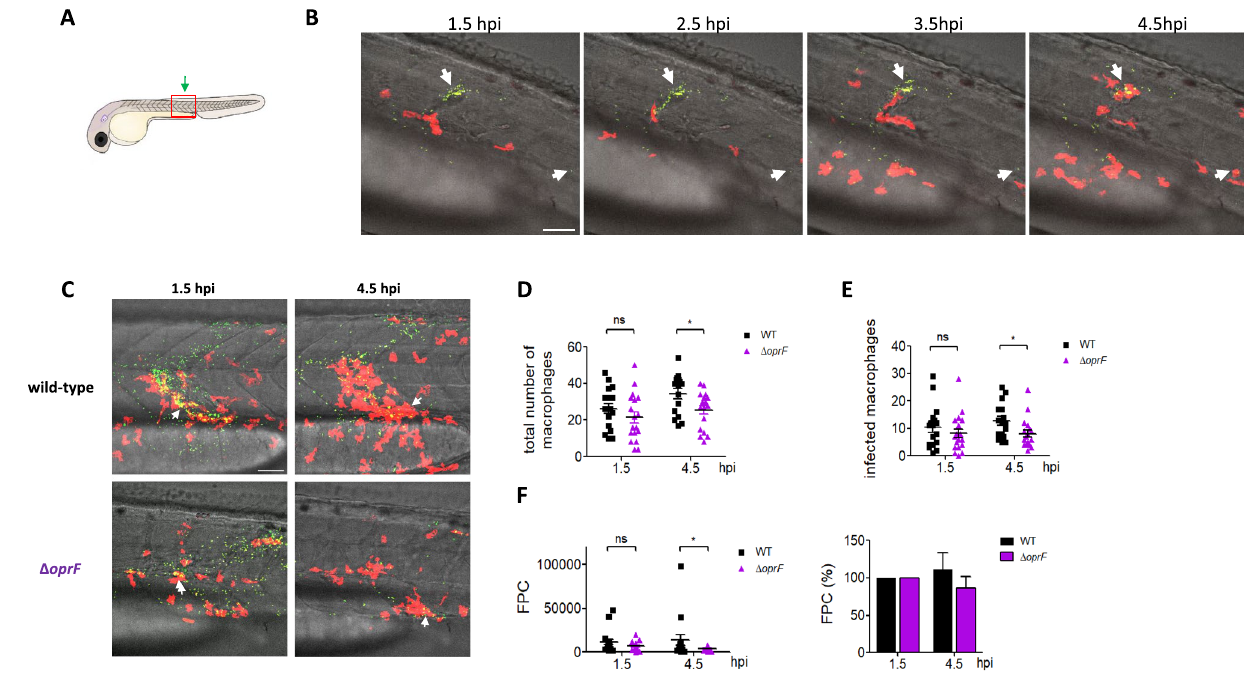
Figure 2. Real-time visualization and quantification of phagocytosis of P. aeruginosa after local injection into muscle of wild-type and Δ oprF strains. ( A ) Illustration of zebrafish larva with the muscle (in red) injection site (green arrow). ( B ) Confocal time-lapse images of tg ( mfap4:mCherry-F ) larva (red macrophages) infected with Δ oprF P. aeruginosa (green) by injection in the muscle. The same area was imaged every hour from 1.5 hpi. White arrows depict GFP-expressing P. aeruginosa that will be taken up by macrophages, which are recruited at the bacterial location. Maximum intensity projection of 96 sections every 1 µm, scale bar 50 µm. ( C ) Confocal time-lapse images of tg(mfap4:mCherry-F) larvae (red macrophages) infected with wild-type or Δ oprF P. aeruginosa (green) by injection in the muscle. The left panel is at 1.5 hpi and the right panel a 4.5 hpi. White arrows depict GFP-expressing P. aeruginosa phagocytosed by macrophages. Maximum intensity projection of 96 sections every 1 µm, scale bar 50 µm. ( D ) Quantification of recruited macrophages at 1.5 and 4.5 hpi, from three independent experiments. Each symbol represents individual embryo (16 to 18 embryos for each strain) and horizontal lines indicate the mean values ± SEM. Statistical significance was determined by two- tailed t test, ns—not significant, * p < 0.05. ( E ) Quantification of infected macrophages, from three independent experiments. Mean ± SEM, two-tailed Mann–Whitney’s test, ns—not significant, * p < 0.05. ( F ) Quantification of bacterial loads (fluorescence pixel counts) from three independent experiments, presented as total value (left) or percentage of the FPC value at first time point (1.5 hpi), counted for each embryo. Mean ± SEM, two-tailed Mann–Whitney’s test, ns—not significant, * p <